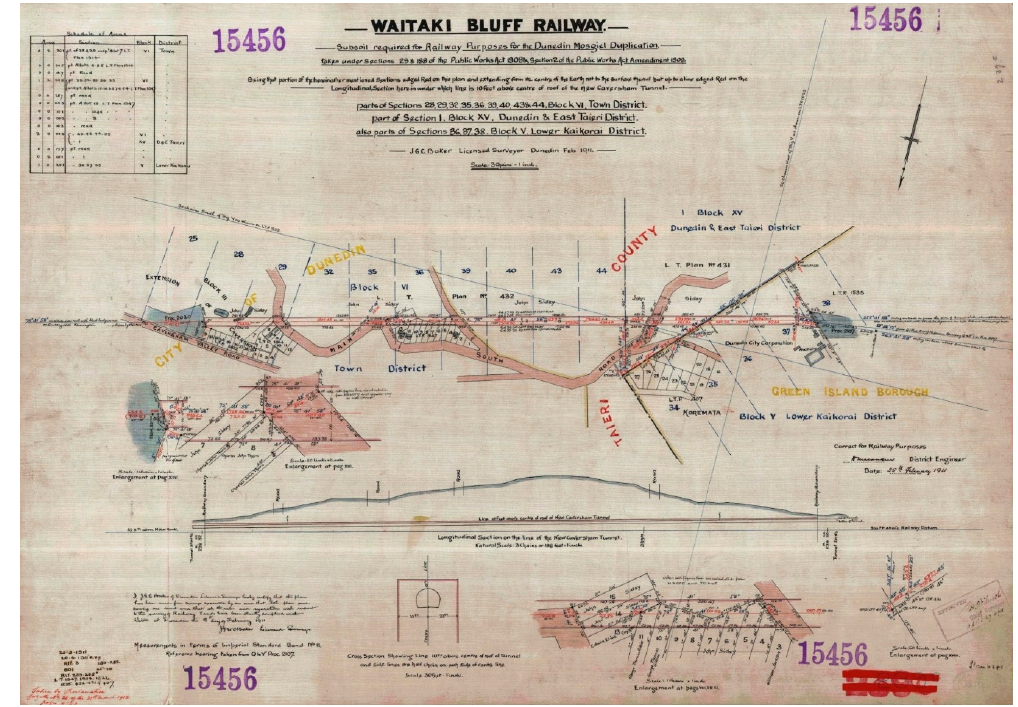
Figure 2. Reference [13] An early example of rights defined in 3D. The 1911 survey plan relates to a railway tunnel in the South Island of New Zealand. The tunnel traverses beneath multiple privately held parcels of land. The upper limit of the railway corridor is restricted in height by way of reference to an offset from a physical structure, being the ceiling of the tunnel. The lower limit of the tunnel is not defined; therefore, it is assumed that the tunnel parcel extends downward to the centre of the Earth.